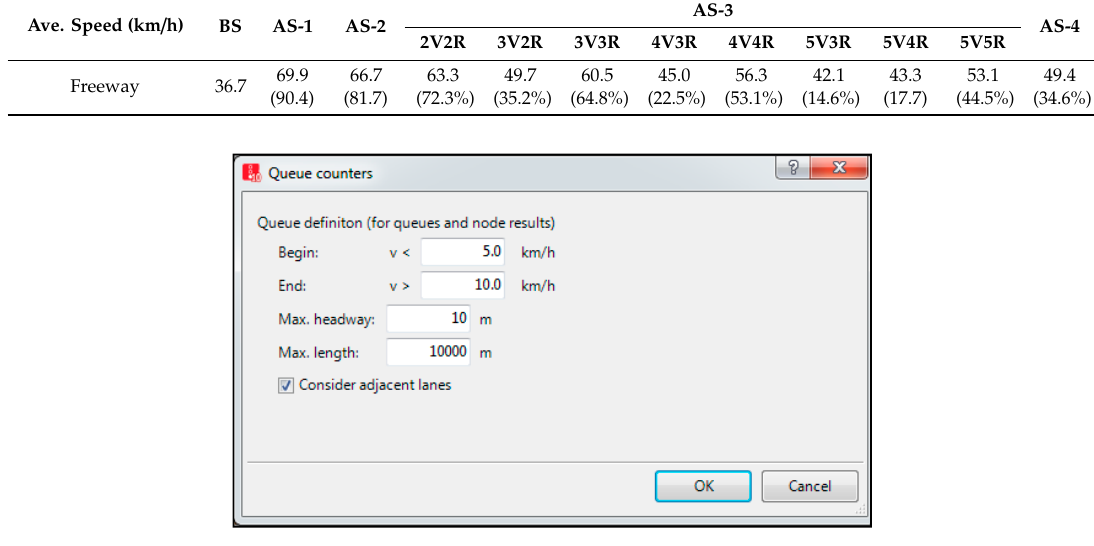
Table 5. Average speed results of each scenario.